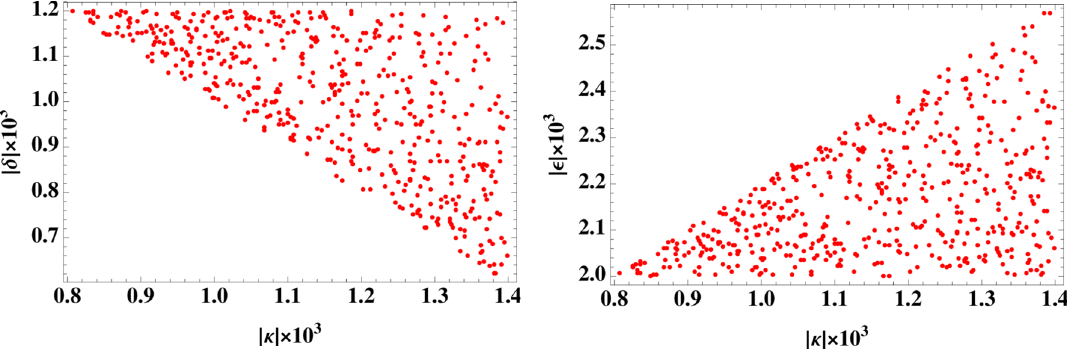
Figure 2 . Left: correlation between κ and δ for parameters satisfying the Atomki constraints. Right: that of κ and (cid:15)